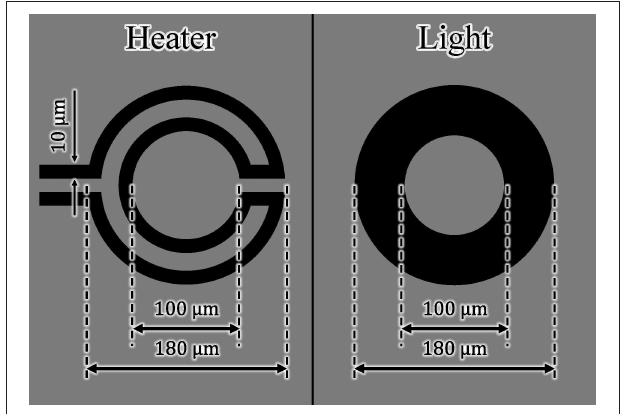
FIGURE 5 | Design of the microheater and light-absorbing pattern for the gel microactuator.